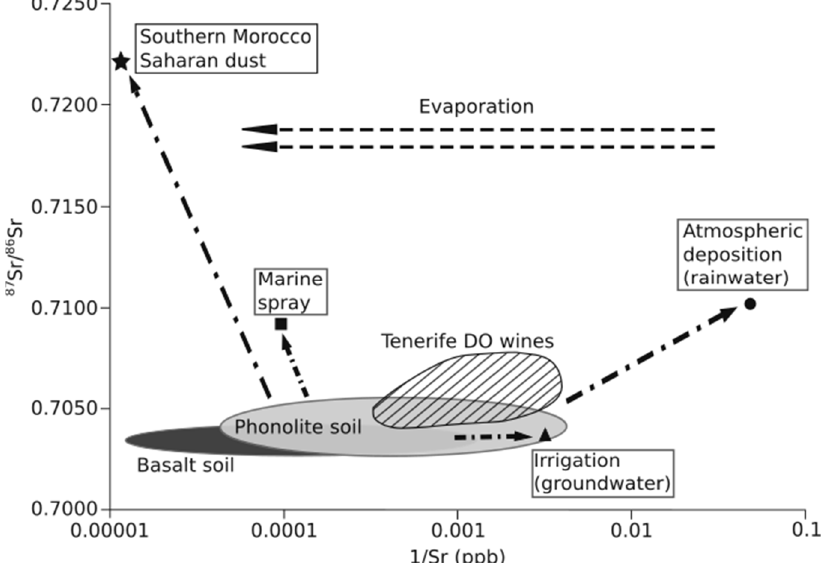
Figure 7. Simple direct-mixing relationships for common natural contaminants to the Tenerife soil system. Two ranges of hypothetical soil compositions are considered, based on dominant island basalt and phonolite (see Table 4). 87 Sr/ 86 Sr values and Sr concentrations typical of soils in relation to their parent rock [23]. Endmembers represent 100% of that contaminant. Southern Morocco Saharan dust compostion is modelled here because it is the dominant contributor to local Calima dust storm events [30]; marine spray composition is that of Atlantic seawater from around Tenerife; local groundwater is considered as proxy for irrigation practices; and atmospheric deposition (rainfall) from a heavy rain event gives the composition of matter scrubbed out of the atmosphere and added to the soil system (which may contain dust and pollution particulates as well as the freshwater rain [62]). Intense evaporation in a desert environment (e.g., in the south of Tenerife) causes an increase in the Sr concentration without affecting the 87 Sr/ 86 Sr composition [63]. Pollution contribution to rainfall similarly increases Sr concentrations [62].